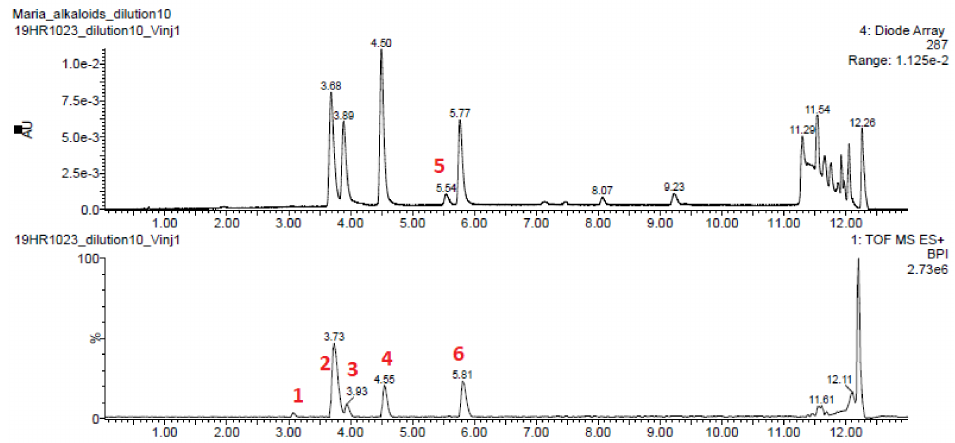
Figure 2. LC-HRMS ESI + analysis of extract 2, UV detection (top) and ion current intensity (bottom). HRMS data are compatible with [M+H] + ions of formula [C 19 H 26 NO 5 ] + (peak 1), [C 18 H 22 NO 5 ] + (peak 2), [C 16 H 18 NO 3 ] + (peak 3), [C 17 H 20 NO 4 ] + (peak 4), [C 18 H 22 NO 4 ] + (peak 5), [C 19 H 24 NO 5 ] + (peak